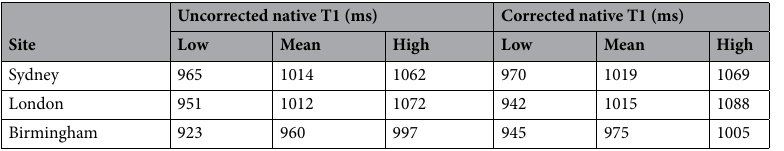
Table 3. Site-specific cutoff values for uncorrected and corrected native T1. A low T1 is considered below the values in the low column, and high above the values in the high column.